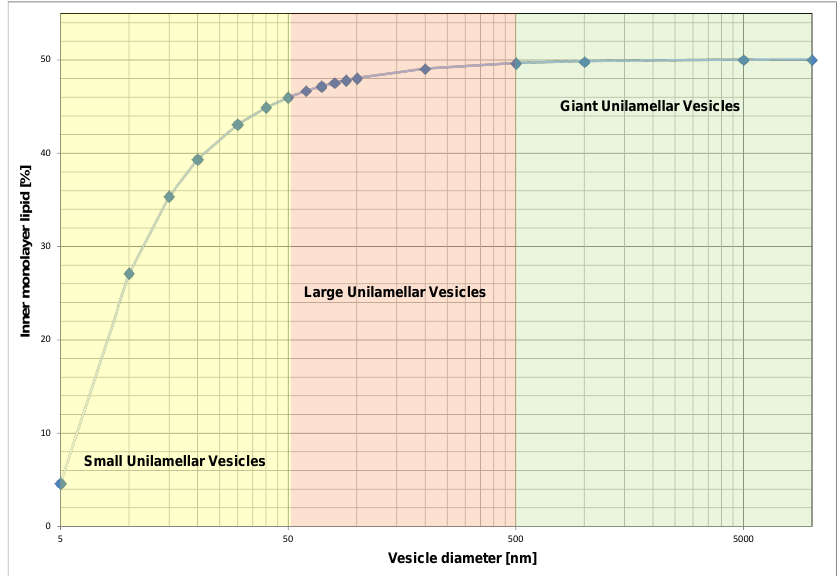
Figure 2. Asymmetric lipid distribution due to vesicle size. Data were generated using the area per lipid and bilayer thickness of 1-palmitoyl-2-oleoyl-sn-glycero-3-phosphocholine (POPC) as determined by Kuˇcerka and co-workers